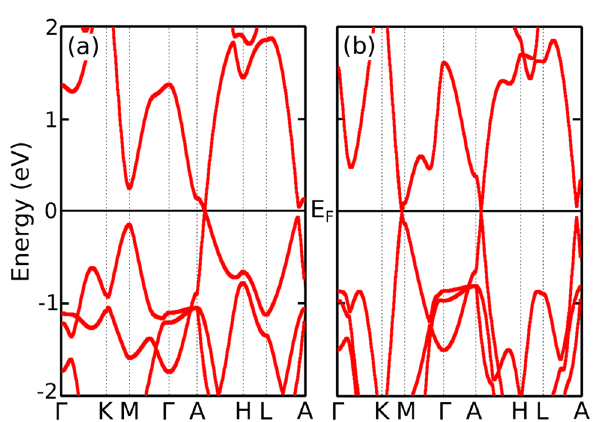
Figure 4. Tight-binding model band structures for BaSn 2 ( a ) for P=0 GPa (T1), the first band crossing point at the A-H line is well reproduced by the model, ( b ) for P=6 GPa (T2), the second band crossing near the M point is also